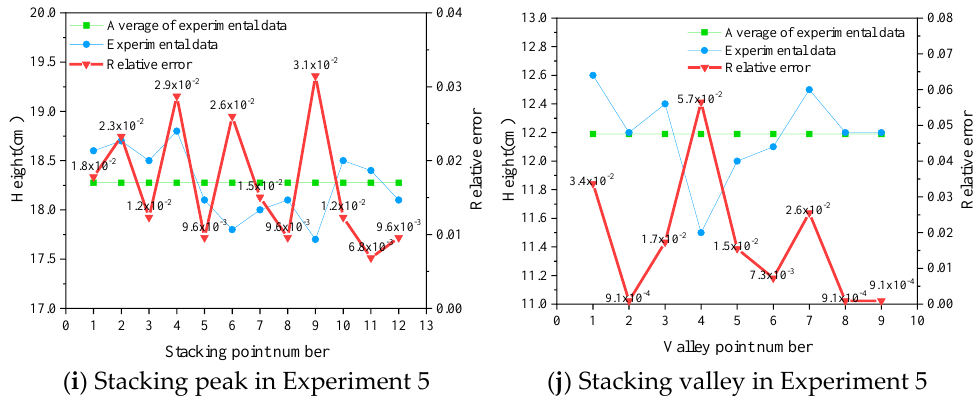
Figure 13. Flatness analysis results of experimental measurement data.